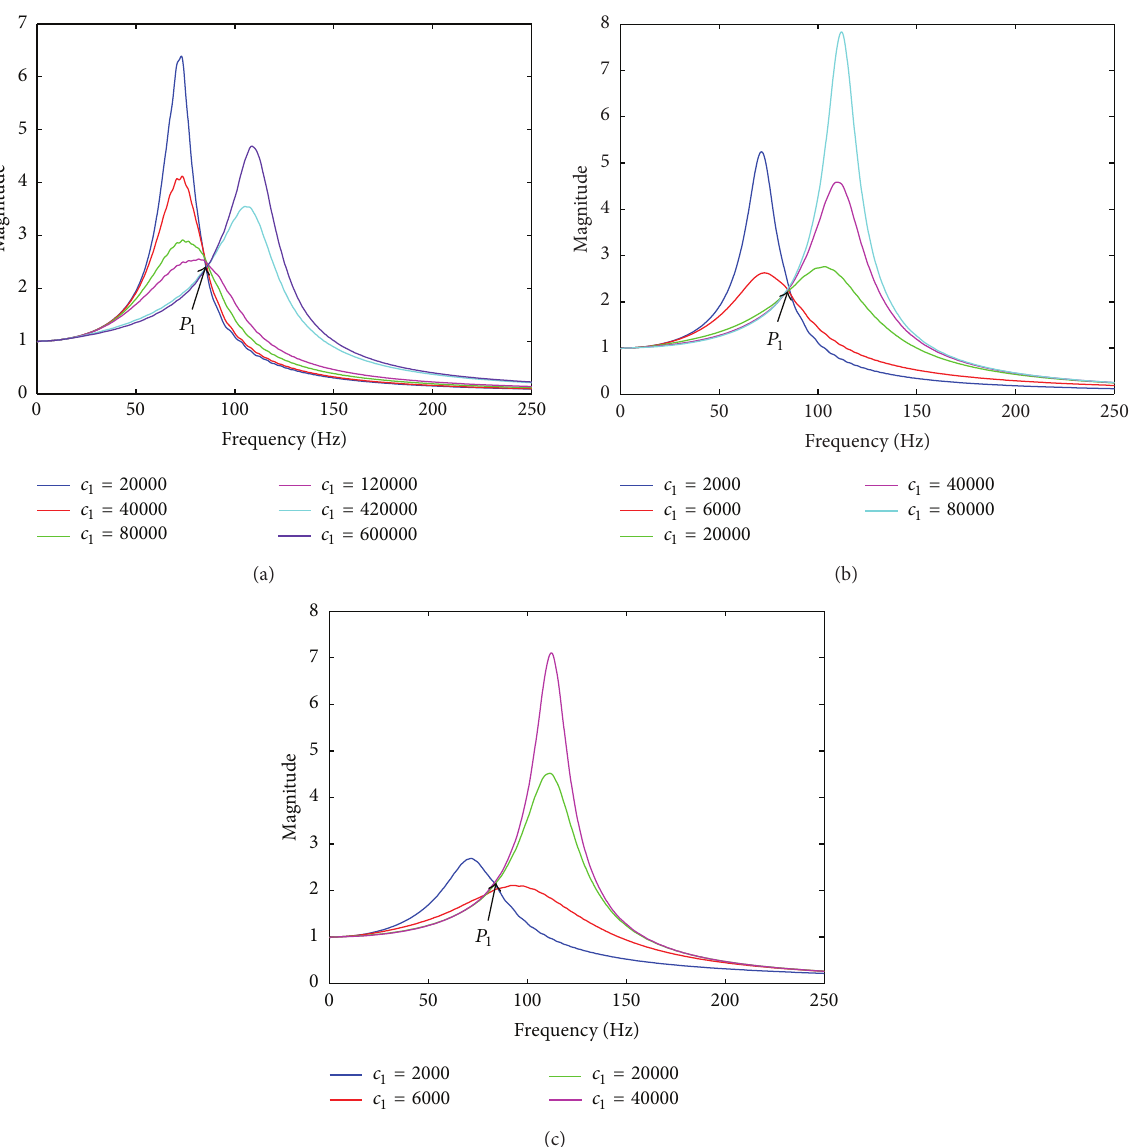
During the test, the whole system is connected to ground to eliminate the effects of electric noise, and a band-pass filter is used to remove the DC component and other interfering frequencies. Figure 6 is a picture of the test